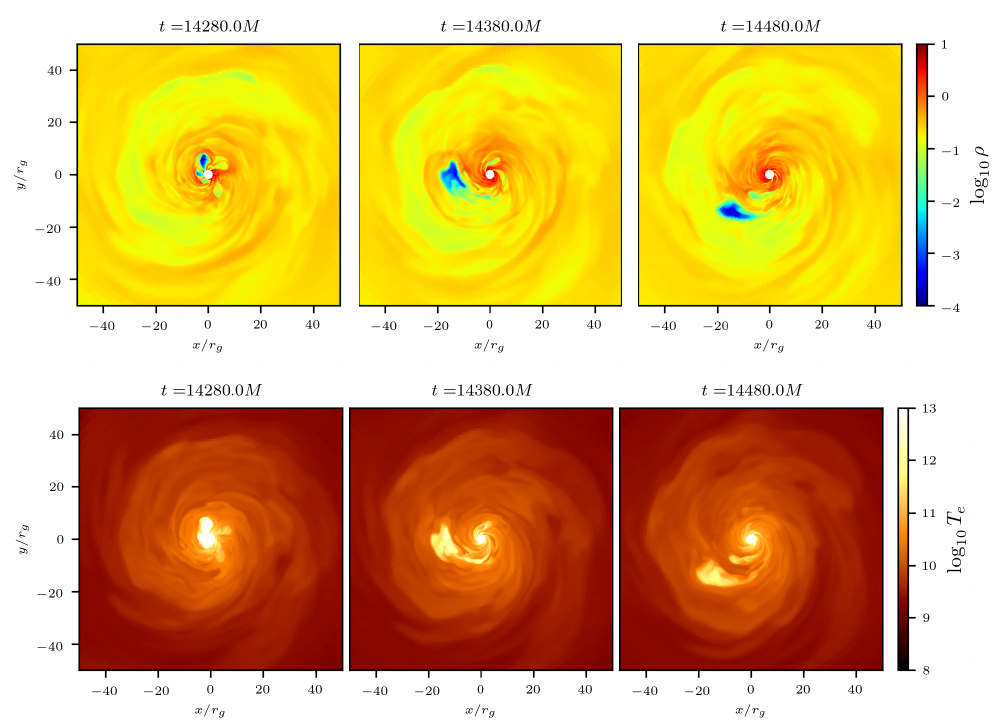
Figure 2. We show equatorial cross-sections of gas density ρ (in arbitrary code units) and electron temperature T e (in Kelvin) during a magnetic flux eruption in the 2t-GRMHD simulation of M87 ∗ . Magnetic flux eruptions, a characteristic feature of magnetically arrested disks, eject bundles of vertical magnetic fields filled with relativistically hot, low-density plasma. These flux bundles spiral around the black hole and may be responsible for high-energy flares [63]. The time unit M is equivalent to r g / c